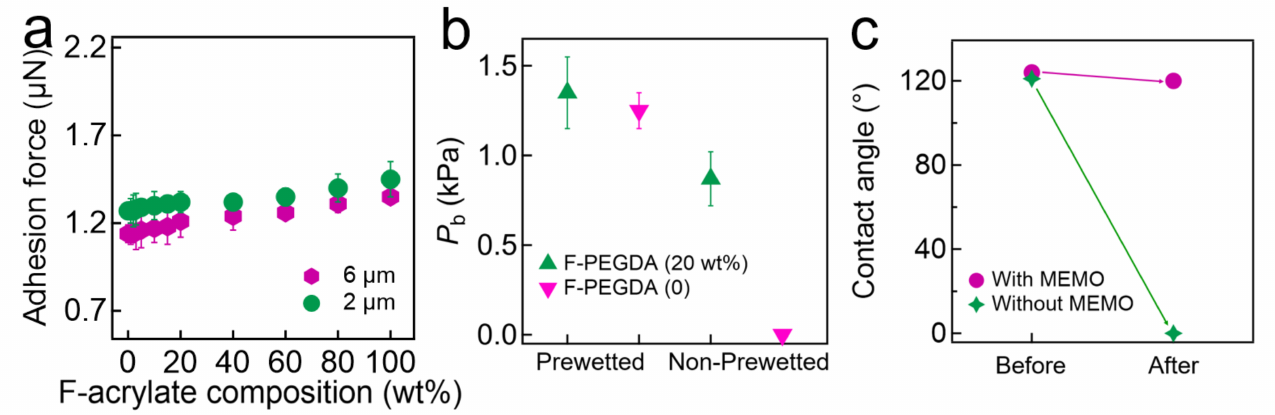
Figure 2. ( a ) The measured adhesion force of a sessile oil (n-hexadecane) droplet on the filter surfaces coated with F-PEGDA with various F-acrylate concentrations. ( b ) The breakthrough pressure of oil on prewetted and dry filters coated with F-PEGDA (20 wt.%). The data obtained from a filter coated with neat PEGDA are also provided for comparison. ( c ) The measured apparent contact angles of oil on the F-PEGDA (20 wt.%), which was prepared with MEMO before and after being submerged in water for 1 h. For comparison, the data for F-PEGDA (20 wt.%) prepared without MEMO are also